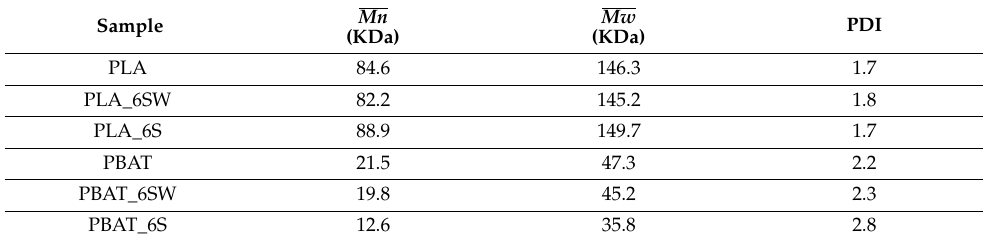
Table 9. GPC results of PLA and PBAT